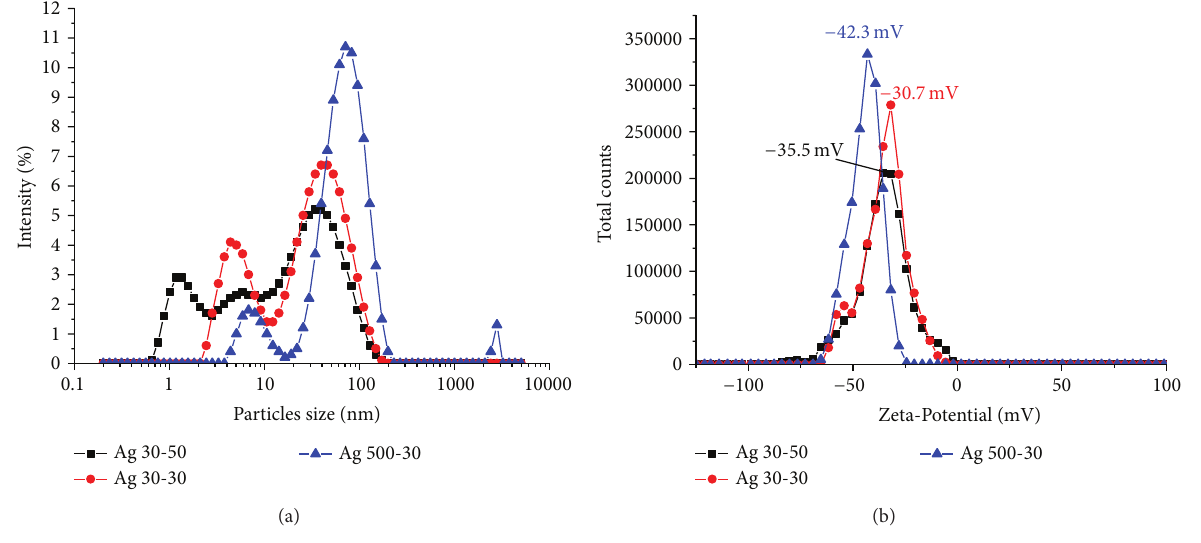
Figure 4: Nanosilver fluid. (a) Particles size analysis; (b) Zeta-Potential analysis.